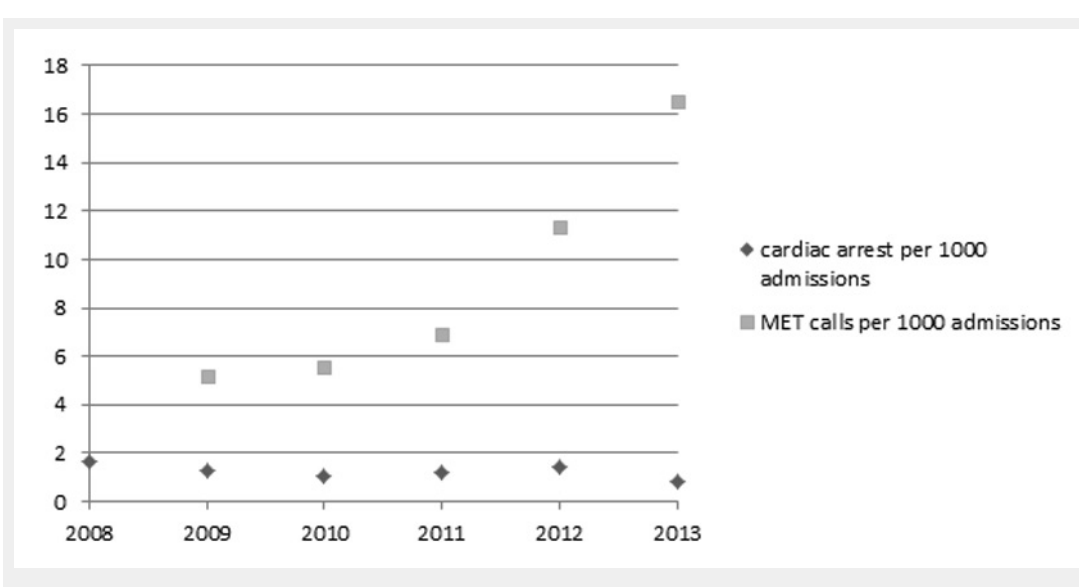
Figure 1 Incidence of MET calls and cardiac arrest calls per 1000 admissions during the study period. During the study period an increase in MET calls from 20 ± 9 calls per month in 2009 to 54 ±11 calls per month in 2013 occurred (p <0.0001), corresponding to an increase in MET calls from 5.2 to 16.5 per 1000 hospital admissions. In the same time period we observed a decrease in cardiac arrest calls in the MET perimeter from 1.6 in 2008 (pre-MET) to 0.8 per 1000 admissions in 2013 (p = 0.014).